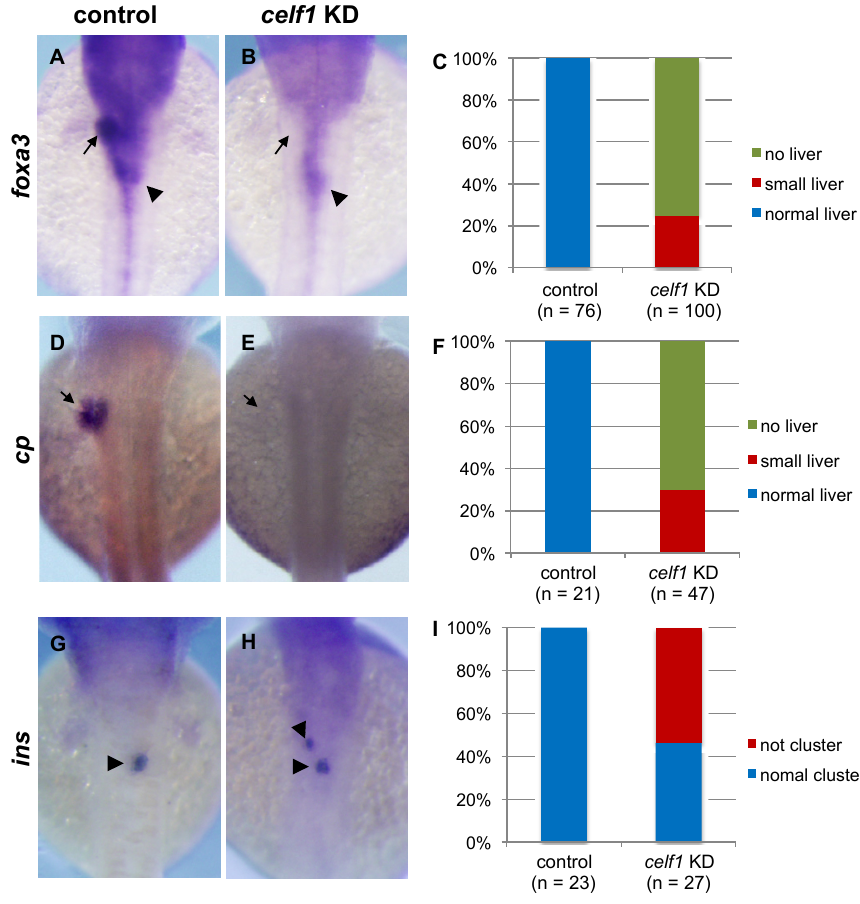
Figure 2. Malformations of endoderm-derived organs in celf1 KD embryos. The expression of foxa3 (gut and its associated organs), cp (liver), and ins ( β -cells in pancreas) was examined in celf1 KD embryos at 48 hpf. Expression of foxa3 was specifically lost at the anterior part of the foregut in celf1 KD embryos ( A – C ). Moreover, the liver buds did not form (arrows, D – F ), and β -cells in the pancreas bud did not form a cluster (arrowheads, G – I ) in the celf1 KD